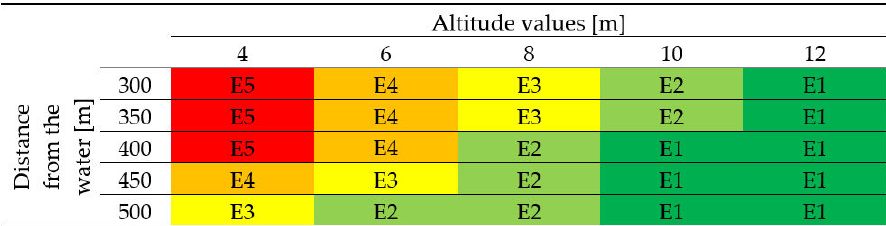
Figure 1. Risk exposure matrix. Level E1 (dark green); E2 (light green); E3 (yellow); E4 (orange); and E5 (red) distributed according to the two factors of exposure: distance from the water and